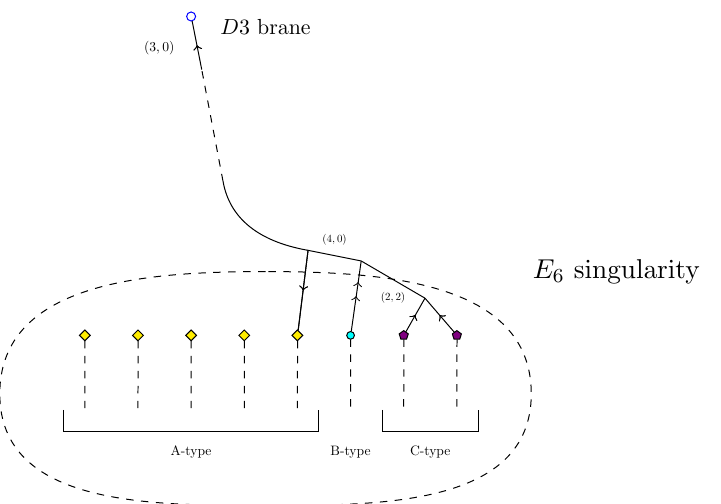
Figure 1 . An example of a string network realization of a BPS state. In particular in the (cid:12)gure is shown the highest weight vector of the 78 with EM charge (3,0).